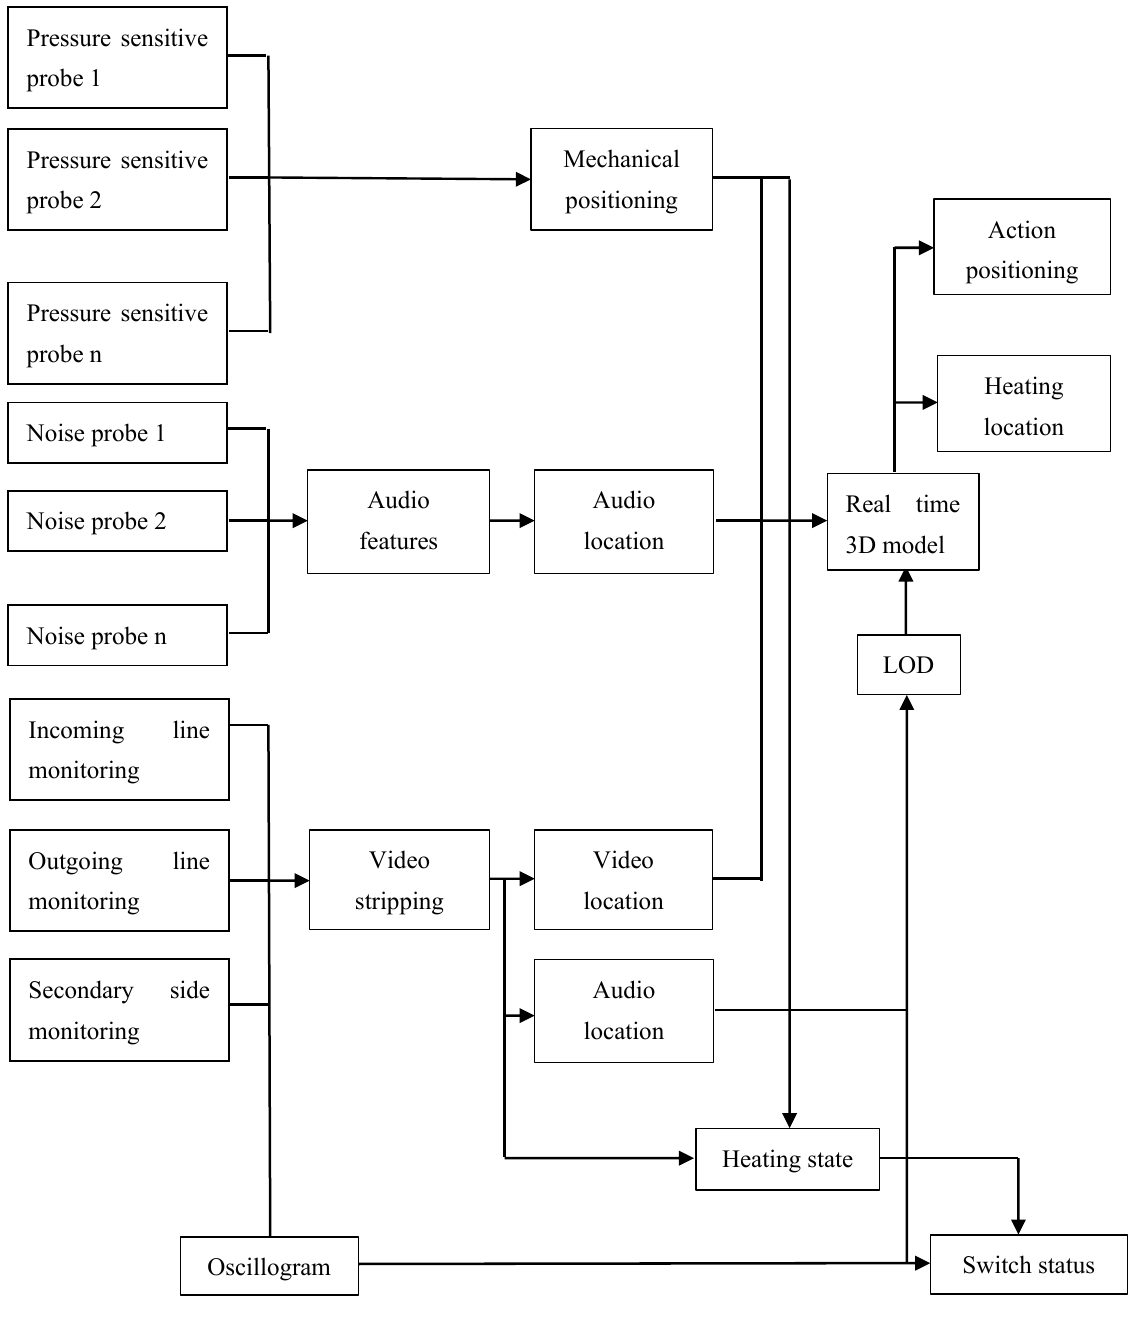
Figure 4. Data collection for generator outlet circuit breaker.